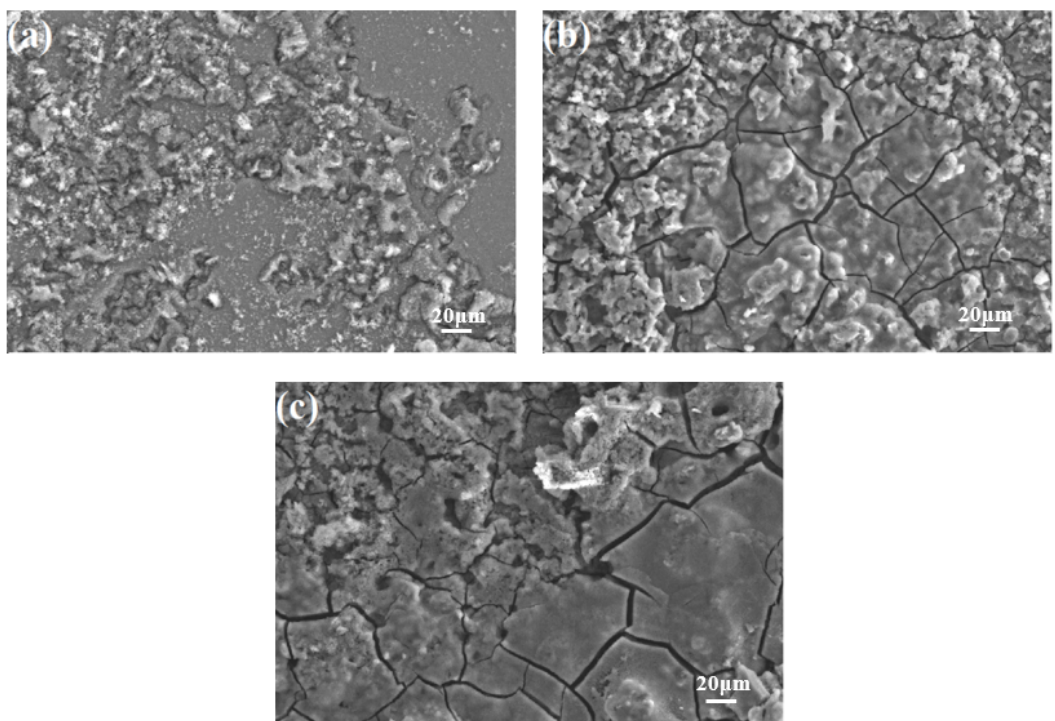
Figure 11. The corrosion morphologies of AZ31-xCaO alloys. ( a ) AZ31; ( b ) AZ31-0.5%CaO; and, ( c ) AZ31-1%CaO.